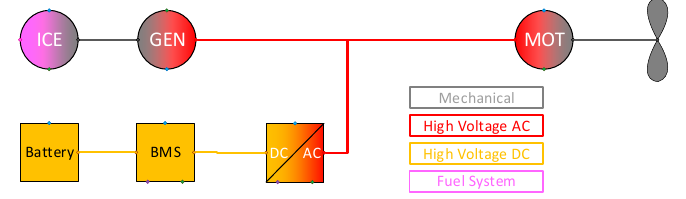
Figure 7. Electric shaft with electric energy storage.